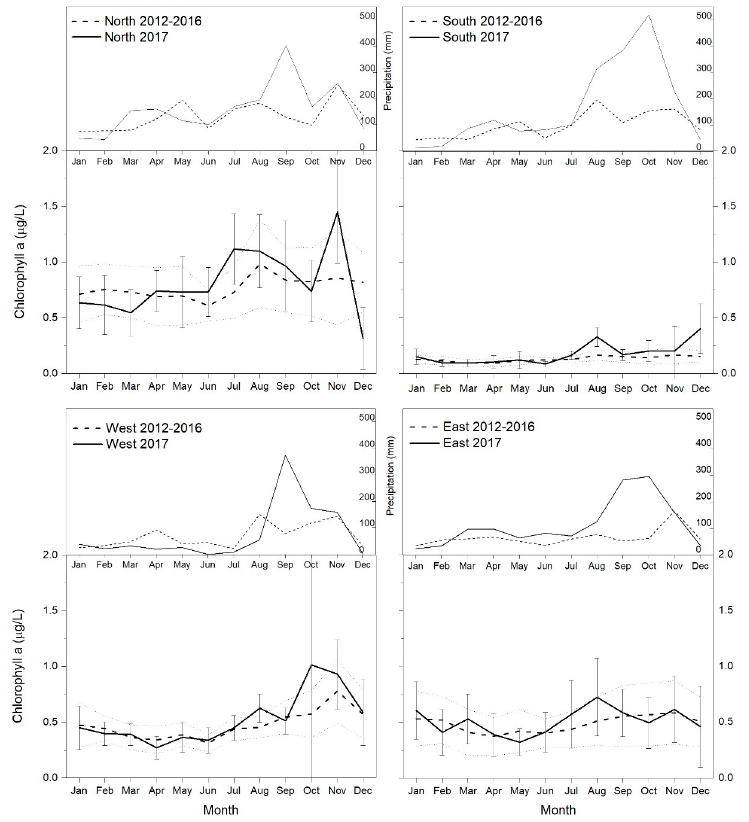
Figure 5. Monthly averaged precipitation and Chl- a concentration with standard deviation by regions for 2012–16 baseline period and 2017. Chl- a concentrations were analyzed monthly for each year to identify the differences between years and the seasonal trends (Figure 6). The higher Chl- a values were observed from July to December 2017 when considering the average of all regions. Chl- a concentration exceeded 0.45 µg/L by August 2017 and persisted until December 2017. Chl- a concentration values above 0.45 µg/L were also present in previous years but never exceeded this threshold for more than 5 months. Average Chl- a concentration for Puerto Rico showed an increase in 2017 when compared with previous values from 2012-2016 especially in the peak of the rainy season (August- November) (Figure 6). The months that showed an increase over the previous baseline values are July (17% higher than baseline), August (36%), September (20%), October (9%), November (14%), and December (13%).